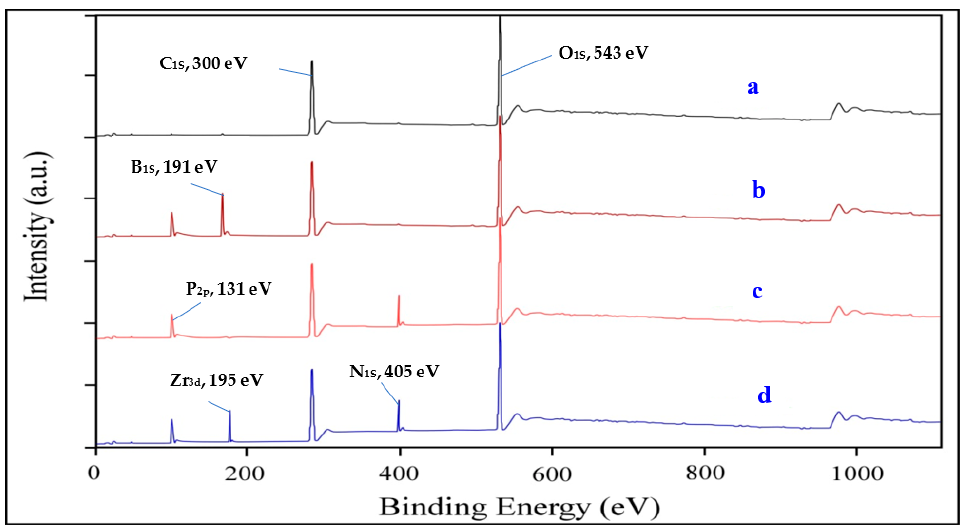
Figure 2. XPS spectra of ( a ) PVA ( b ) PPVA ( c ) PPVP and ( d ) PPVP-Zr. Table 1. Chemical composition of PVA, PPVA, PPVP and